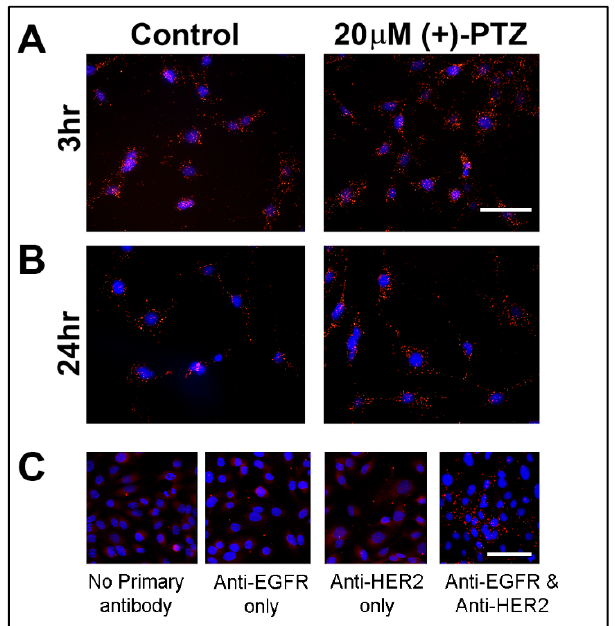
Figure 2. Proximity ligation assay (PLA) for Sig1R and Nrf2 in 661 W cells. The 661 W cells were incubated in the presence or absence of (+)-PTZ (20 μ M) for ( A ) 3 h or ( B ) 24 h. Cells were subjected to the PLA assay using rabbit anti-Sig1R and mouse anti-NRF2. Fluorescent images were captured and orange-red puncta represent co-localization of Sig1R and NRF2. To confirm the validity of the assay, we used the Duolink PLA Control Kit, which provides SK-OV-3 human ovarian cancer cells that were treated with EGF to detect two proteins known to co-localize following EGF treatment (EGFR and HER2). ( C ) When no antibody was present or when only one antibody was present (anti- EGFR only, anti-HER2 only), no orange-red fluorescent puncta were detected; however, when both antibodies (anti-EGFR and anti-HER2) were present in the assay, abundant orange puncta were visible. DAPI (4 ′ , 6-diamidino-2-phenylindole), a fluorescent stain, was used to detect cell nuclei. Calibration bar = 30 μ m.